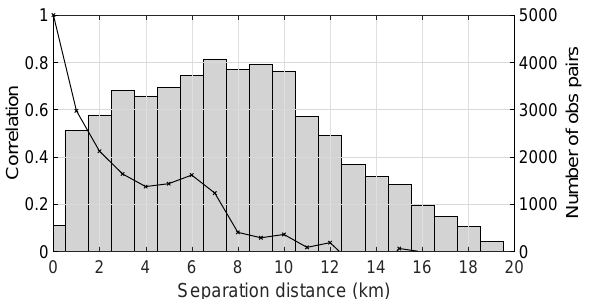
Figure 3. Estimated SAR WLO error correlations (black line) and number of samples (bars) used (bin width = 1km), west domain. Estimated error standard deviation is